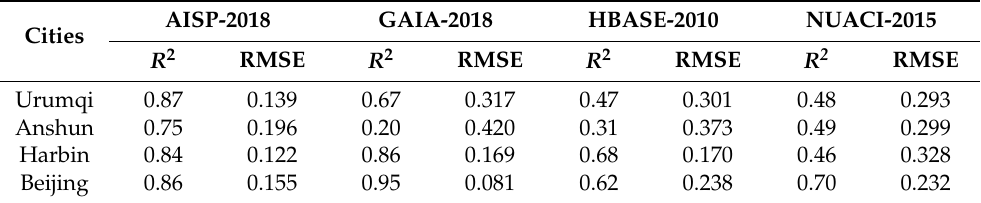
Table 6. Accuracy of the four impervious surface maps over 4 validation regions.